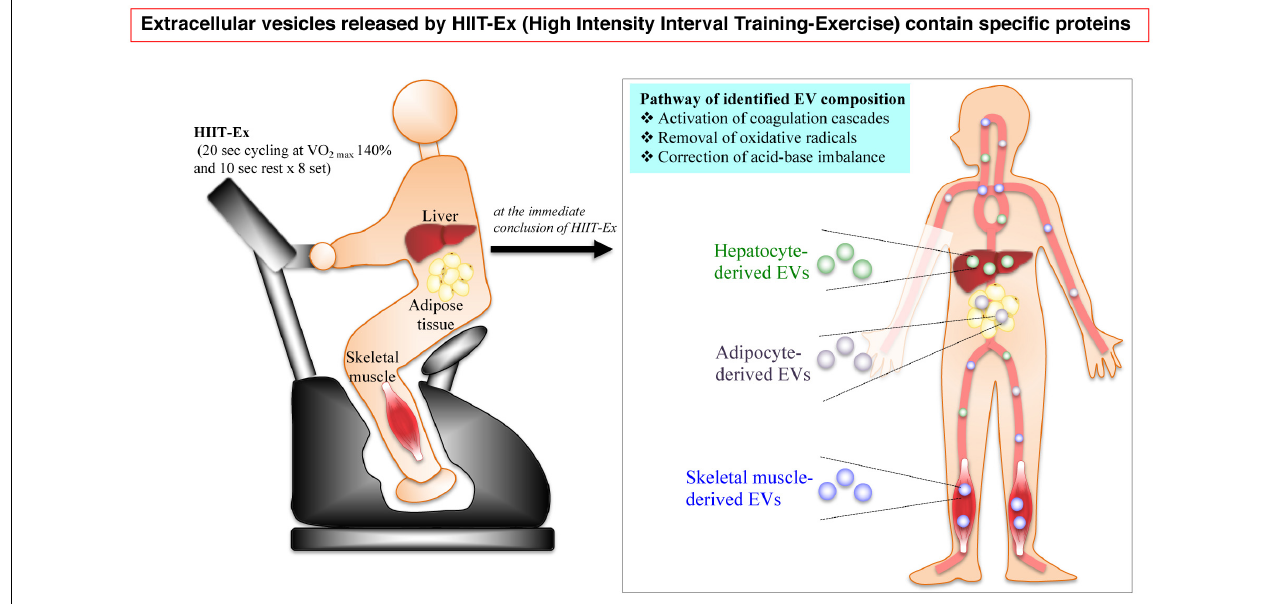
FIGURE 6 | A schematic illustration of the HIIT-EX advantage on EV release from organs associated with metabolism. HIIT-EX enhances EV release from organs including liver, adipose tissue, and skeletal muscle associated with metabolism. These EVs contain specific proteins relating to several